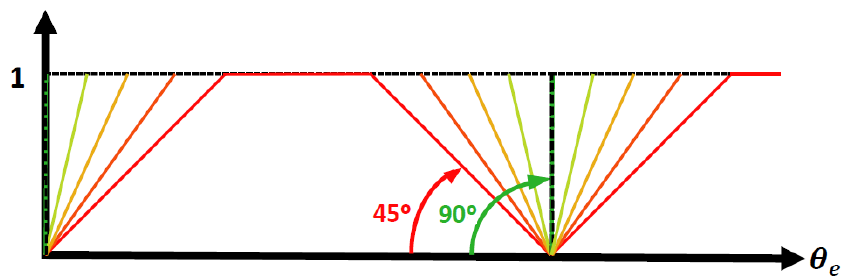
Figure 9. Dynamic waveform used to impose the current in the BLDC motor operating under phase fault.